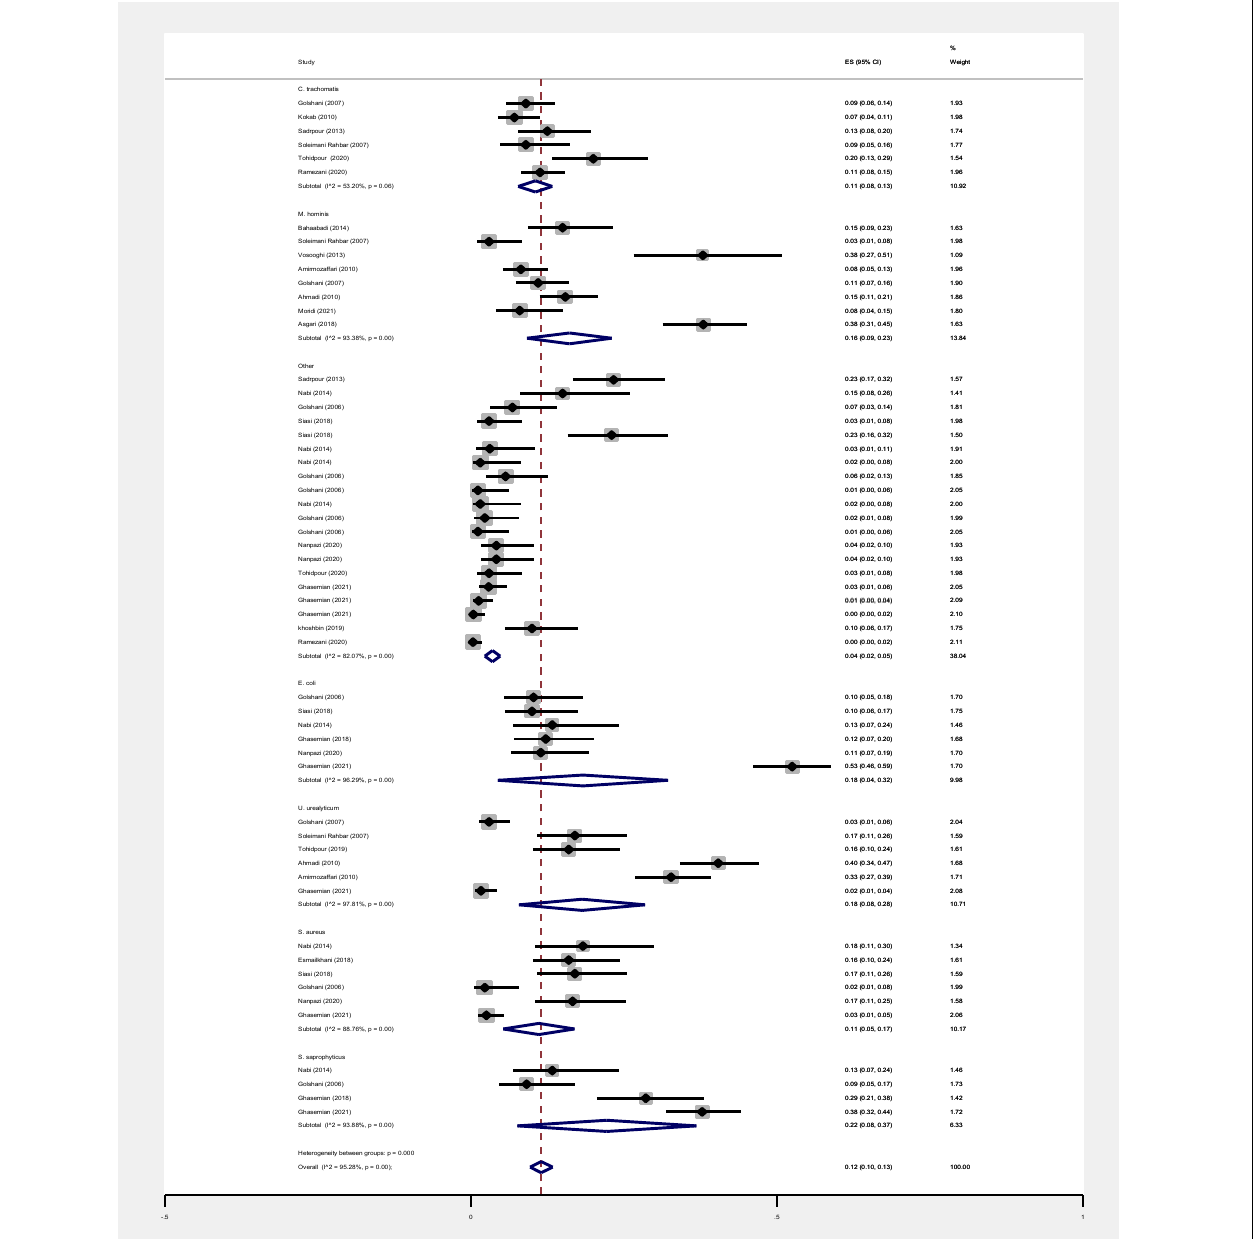
between HCMV, CMV, and HPV and male infertility